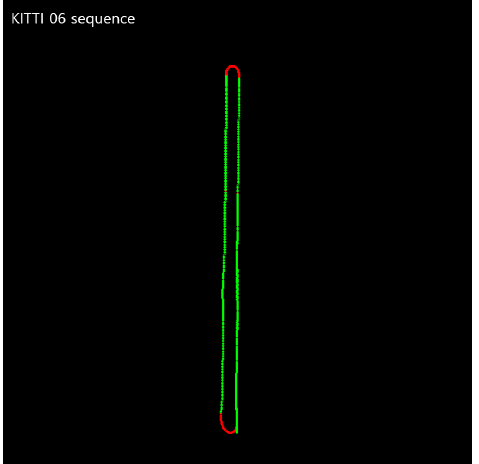
Figure 9. Ground truth trajectory from RTK-GPS (Real-Time Kinematic Global Positioning System) of KITTI 06 sequence; the red trajectory is the section where the yaw angle exceeds the threshold and the green trajectory corresponds to the remaining section where the yaw angle falls below the threshold.